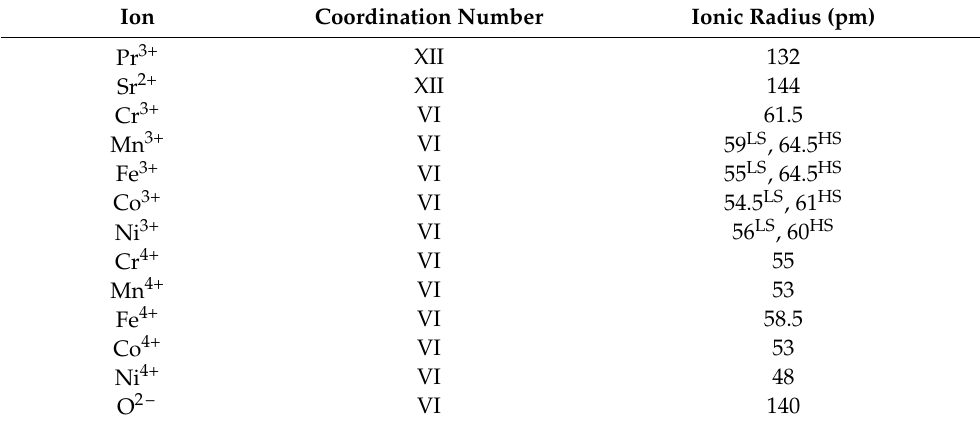
Table A1. Ionic radii of elements in Pr 1– x Sr x (Cr,Mn,Fe,Co,Ni)O 3– δ ( x = 0–0.5) [50,51]. LS and HS stand for low spin and high spin, respectively.